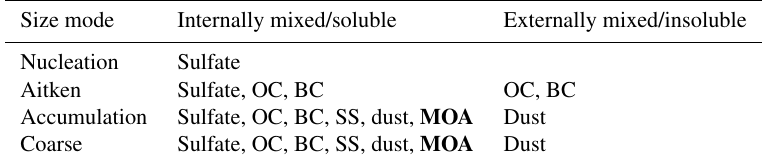
Table 1. List of aerosol species present in each of the seven modes. In bold are tracers added in the current study. Size mode Internally mixed/soluble Externally mixed/insoluble Nucleation Sulfate Aitken Sulfate, OC, BC OC, BC Accumulation Sulfate, OC, BC, SS, dust, MOA Dust Coarse Sulfate, OC, BC, SS, dust, MOA